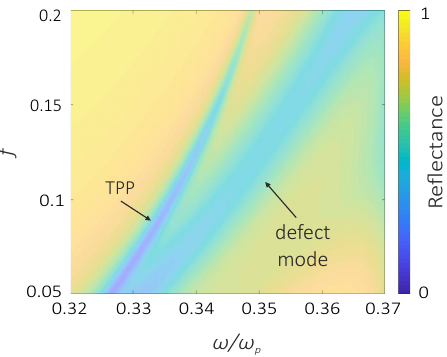
Figure 4. Reflectance spectra of the PhC/nanocomposite structure at the normal incidence of light onto the sample at different nanocomposite filling factors. The nanocomposite layer thickness is d eff = 300 nm.